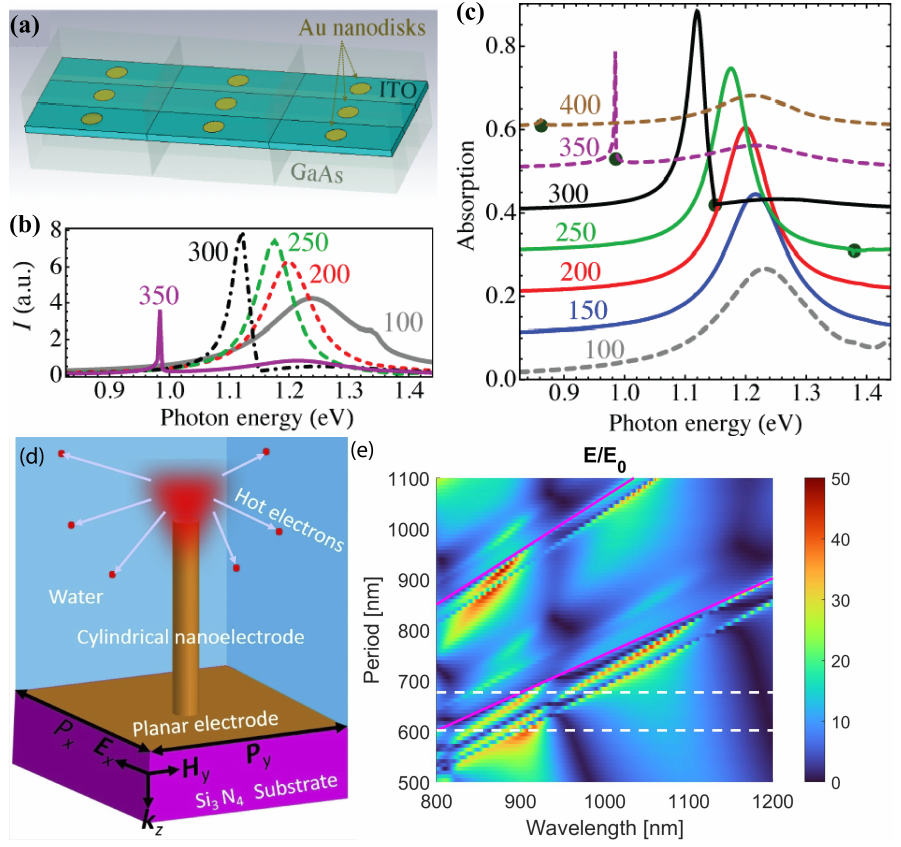
Figure 5. ( a ) Schematics, ( b ) photocurrent spectra, and ( c ) absorption spectra for the nanostructure designs with various array periods p x . The nanodisk array is embedded in a transparent conductive oxide film and sandwiched between galium arsenide layers, providing a gold - galium arsenide interface at the front and back facets of the nanodisk. Incident light is y -polarized. The nanodisk radius is r = 25 nm and the height is h = 18 nm. Period p y along the y -direction is fixed to 100 nm. In panel ( b ), for clarity, each absorption spectrum is vertically shifted by 0.1 when the array period changes by 50 nm. ( d , e ) Nanostructure design aimed at improving hot-electron generation in nanoelectrodes. ( d ) Unit cell. The upper half-plane of the nanotube and planar electrodes are situated in water and have been positioned on a silicon nitride substrate. ( e ) The enhancement of electric field ( E / E 0 ) in an array of gold nanoelectrodes at a specific probe position varied for different lattice periods P . The enhancement can achieve values of up to 50 times, particularly in resonances that follow Rayleigh anomalies. The periods are P = P x = P y in the x - and y -directions. The cylindrical gold nanoelectrode (nanotube) has a height of h = 1800 nm and an internal radius of 60 nm. The nanotube consists of walls that are 30 nm thick and is connected to a planar gold electrode of the same thickness. The wave propagates in the z -direction and is polarized in the x -direction. The solid magenta lines correspond to the Rayleigh anomalies (1,0) and (1,1). ( a – c ) Reproduced with permission from [78]. Copyright 2014 Springer Nature. ( d , e ) Reproduced from